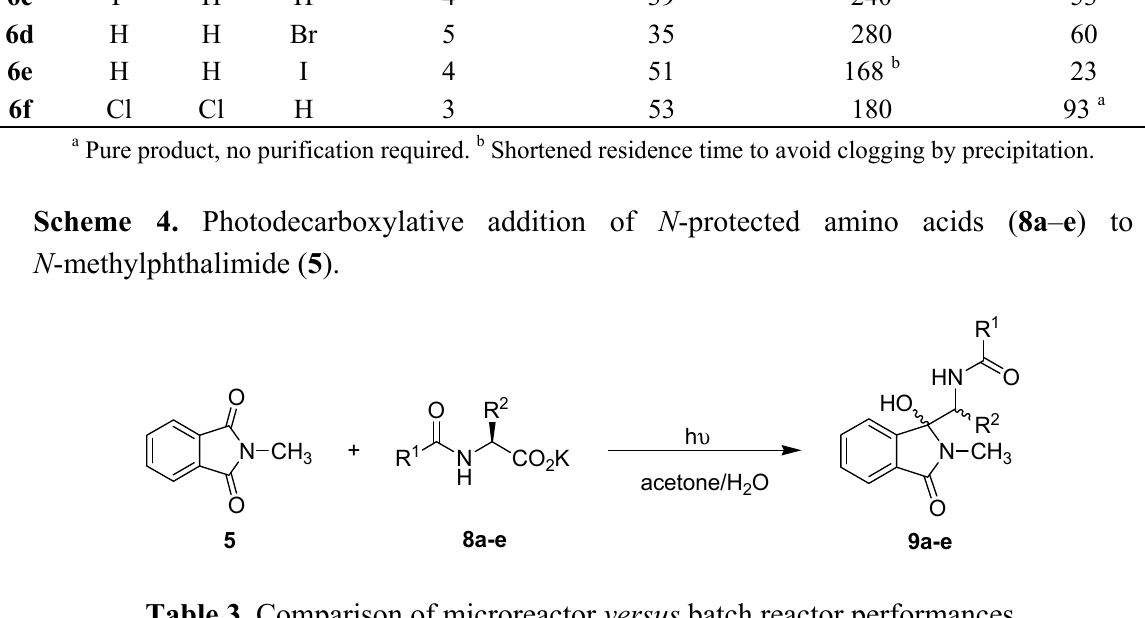
Table 3. Comparison of microreactor versus batch reactor